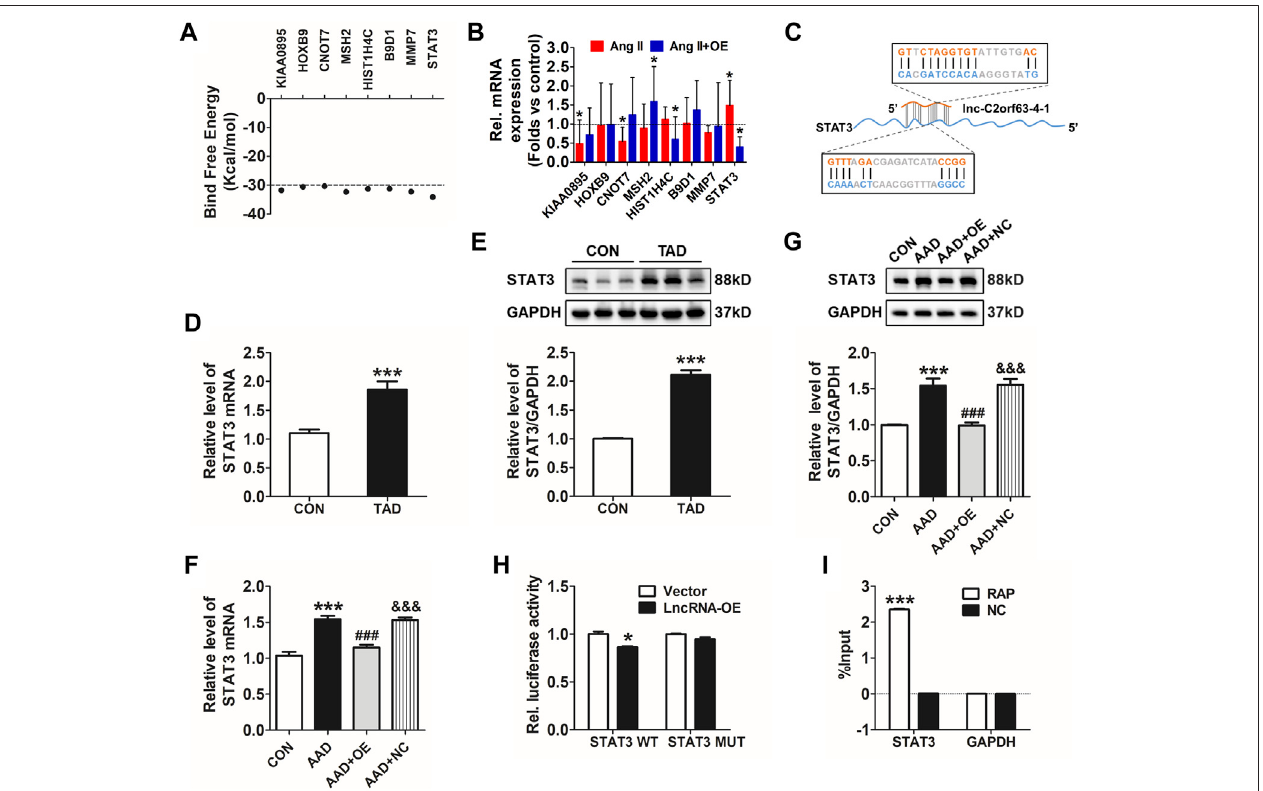
FIGURE 7 | Lnc-C2orf63-4-1 directly interacts with STAT3. (A) Predicted panel of transcription factors potentially interacting with lnc-C2orf63-4-1, exploiting bindingfreeenergybelow − 30 kcal/mol. (B) qRT-PCRmeasurementofthepaneloftranscriptionfactorsuponAngIIwithorwithoutlnc-C2orf63-4-1(AngII+OE). (C) The binding sites of the STAT3 transcription factor with lnc-C2orf63-4-1 were predicted by LncTar (http://www.cuilab.cn/lnctar). (D) Detection of STAT3 mRNA using qRT- PCRintheaortasamplesofhealthydonorsandclinicalTADpatients( n (cid:1) 6 – 10/pergroup). (E) RepresentativeWesternblottingimagesandquanti fi cationofSTAT3 inaortasamplesofhealthydonorsandclinicalTADpatients( n (cid:1) 6 – 10/pergroup). GAPDHwasused forinternalnormalization. (F) Theexpression levelofSTAT3inaorta tissueofallgroupswasevaluatedbyqRT-PCR( n (cid:1) 4 – 6/pergroup). β -actinwasusedfornormalization. (G) RepresentativeWesternblottingimagesandquanti fi cationof STAT3inaortatissueofallgroups( n (cid:1) 4 – 6/pergroup).GAPDHwasusedforinternalnormalization. (H) Dual-luciferasereporterassayofWTandMutSTAT33 ′ UTR.( n (cid:1) 4/per group). * p < 0.05 vs. Vector group. (I) Identi fi cation of mRNA by RAP. No RAP probes were used for the input control. Percentage ofpuri fi ed mRNA relative to the inputgroup,asdetected byqRT-PCR.( n (cid:1) 3/pergroup). *** p < 0.001vs.Normalgroup.Dataof (D,E) werecompared byStudent ’ st-test.Dataof (G – I) werecompared by analysis-of-variance (ANOVA) with Bonferroni ’ s post-test. Data were all expressed as mean ± SEM. * p < 0.05, *** p < 0.001 vs. control or vector group, ### p < 0.001 vs. AAD group, &&& p < 0.001 vs. AAD + OE group.